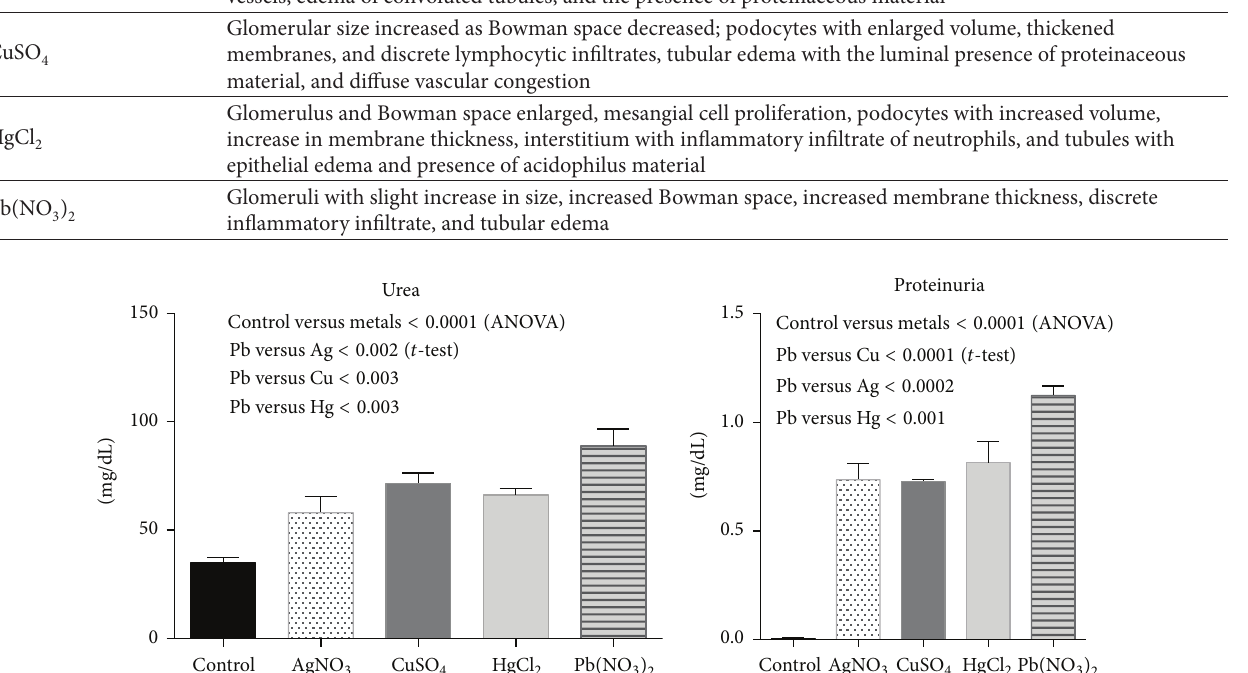
Figure 1: Urea and proteinuria determined at the beginning of the trial (control) and at the end of the intoxication trial. The graphs show the mean and standard deviation